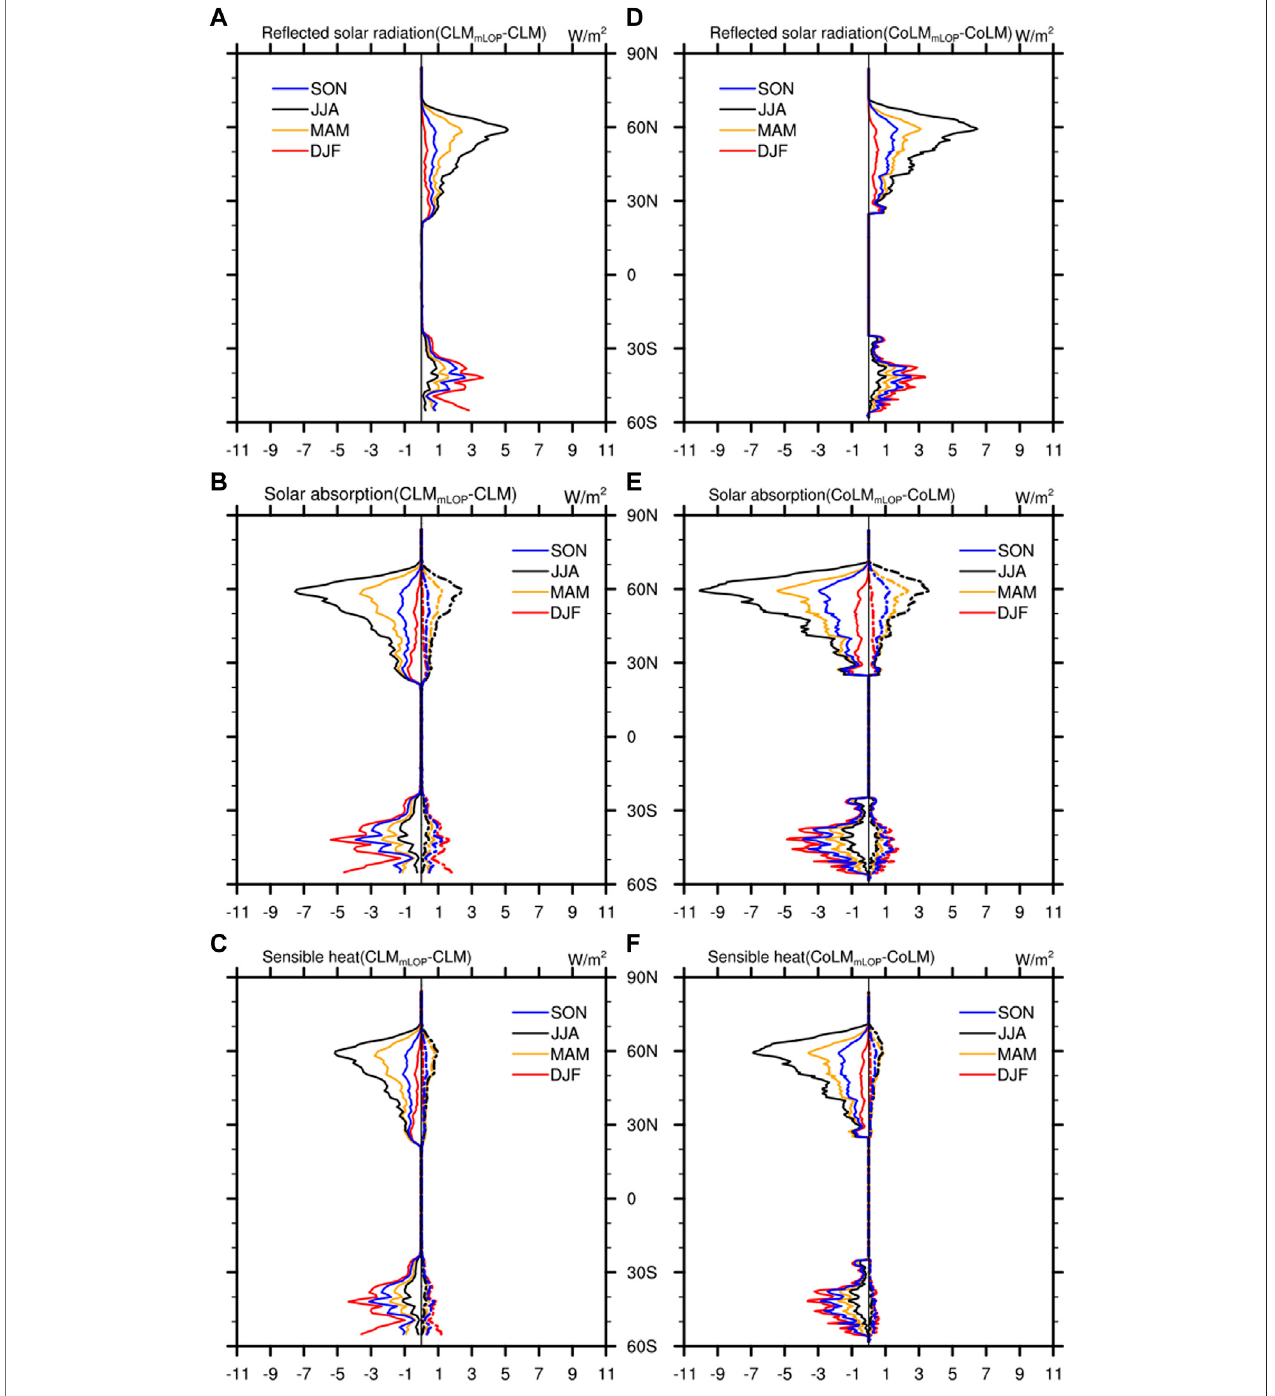
FIGURE 6 | Zonal average differences in re fl ected solar radiation (A,D) , solar absorption (B,E) and sensible heat fl ux (C,F) between CLM (CoLM) and CLM mLOP ( CoLM mLOP ). The solid line and dashed line in Figure 6B,C and Figure 6E,F represent vegetation and the ground,